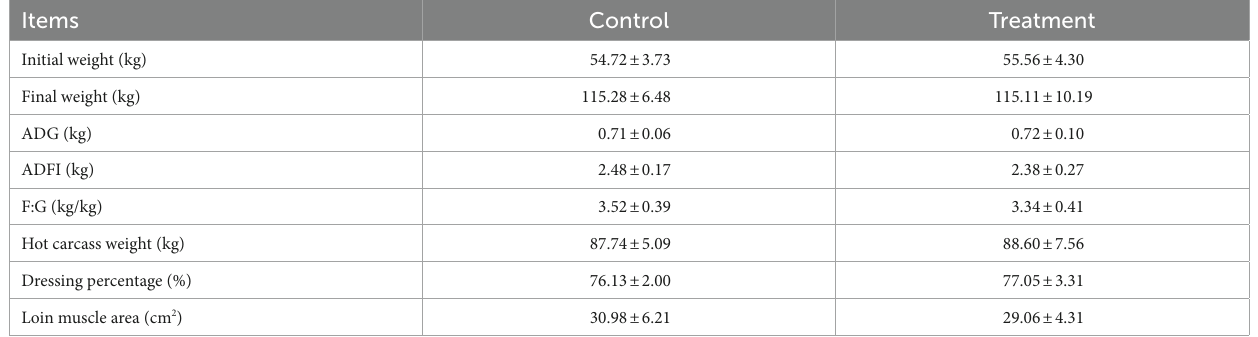
TABLE 1 Effect of grape residue meal on carcass traits of longissimus thoracis in pigs. Items